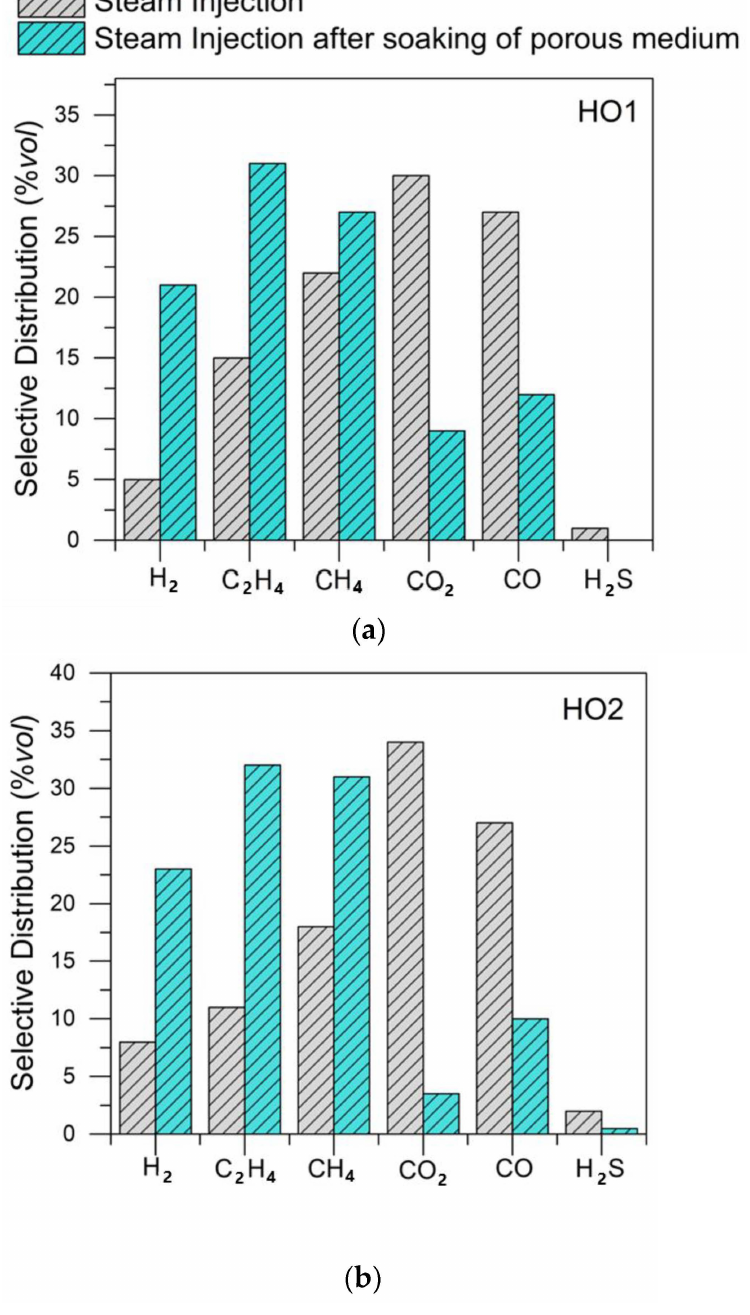
Figure 4. Selectivity distribution of light gases produced from steam gasification of ( a ) HO1 and ( b ) HO2 at reservoir conditions in the presence and absence of